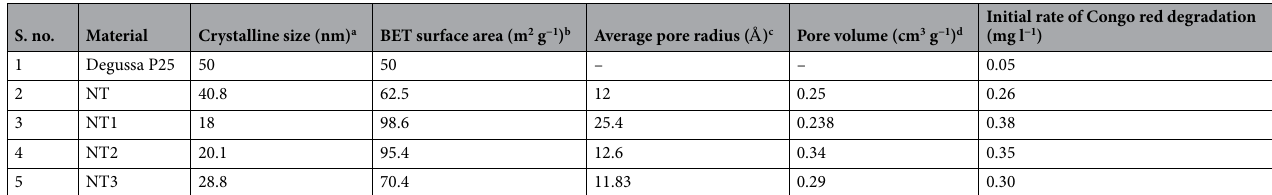
Table 1. Physico-chemical parameters of the synthesized samples. a Average crystalline size was determined by XRD using Scherrer equation. b The BET surface area was determined from the linear part of the graph. c Calculated from the desorption branches of isotherms. d Estimated by BJH method.